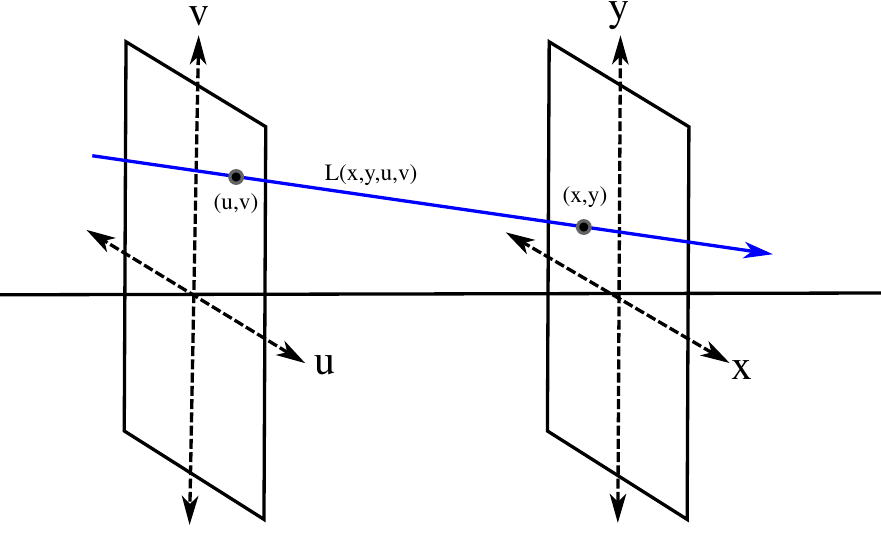
Figure 1. Two-plane parameterization of a light field.